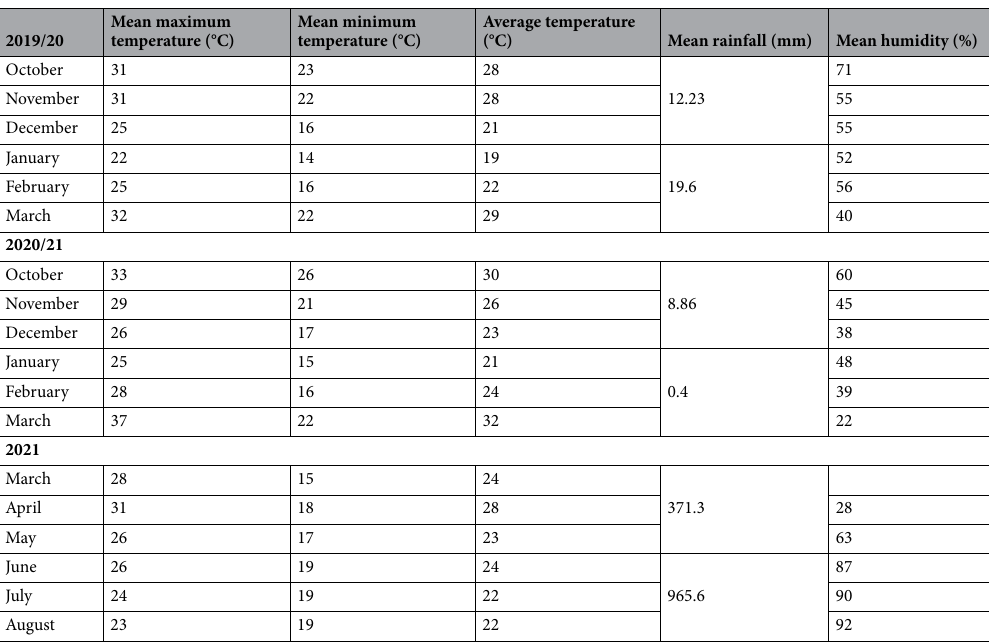
Table 1. The monthly mean maximum and minimum temperatures with rainfall and humidity data for the winter and summer season maize growing periods of Malangawa Sarlahi (2019/2020 and 2020/2021) and Khumaltar Lalitpur (2021), Nepal. Experimental site weather data retrieved from https:// www. world weath eronl ine.